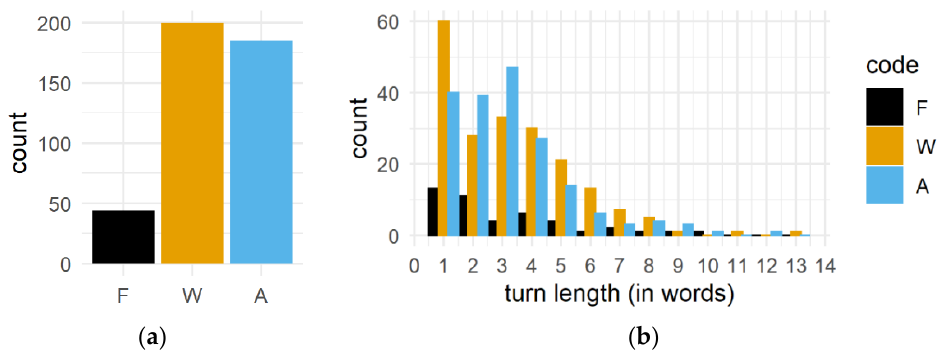
Figure 1. ( a ) Count of turns coded in each register type; ( b ) distribution of turn lengths in words, by